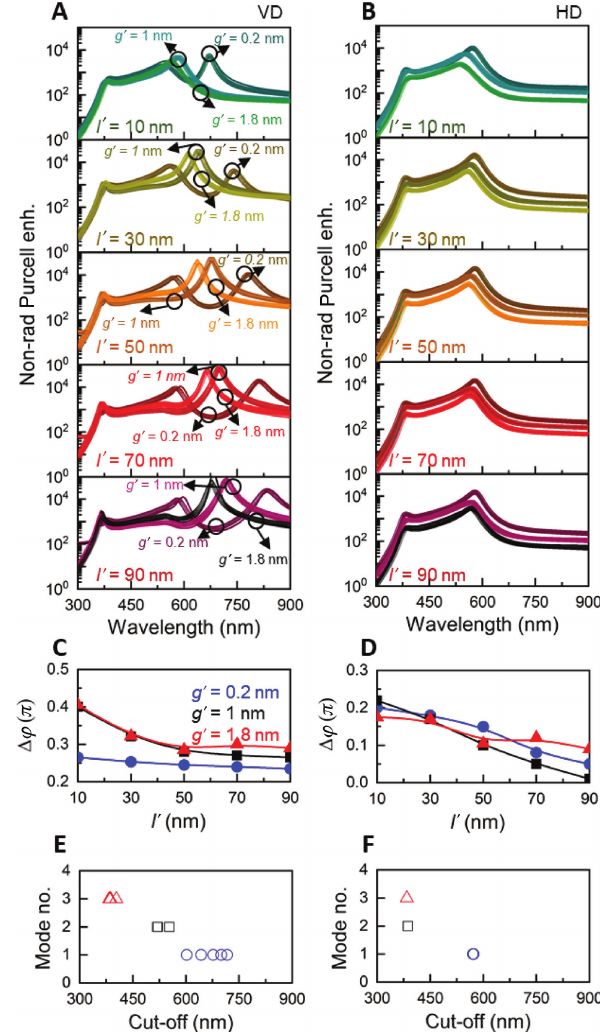
Figure 2: Influence of the bowtie nanoantenna’s length ( l ′ ). The analytical (symbols) and numerical (solid lines) results of the Γ for θ ′ = 20 ° bowtie nanoantenna of varying length l ′ and gap nr size g ′ illuminated by a nanoemitter with vertical (A) and horizontal (B) polarizations placed at ( x ′ , y ′ ) = (1 nm, 0 nm). Notice that the symbols and solid lines overlap and are largely indistinguishable. Phase correction Δ ϕ as a function of l ′ for the vertical (C) and horizontal nanoemitters (D) for the three gap sizes considered in A and B. The cut-off wavelength for the first three localized surface plasmon modes with a vertical (E) and horizontal nanoemitter (F) when g ′ = 1 nm. Notice that the cut-off wavelength for all modes is rather stable against g ′ for the horizontal nanoemitter